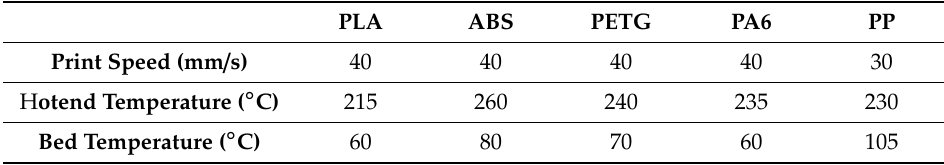
Table 2. 3D printing settings used on the Intamsys Funmat HT 3D printer for the manufacturing of the